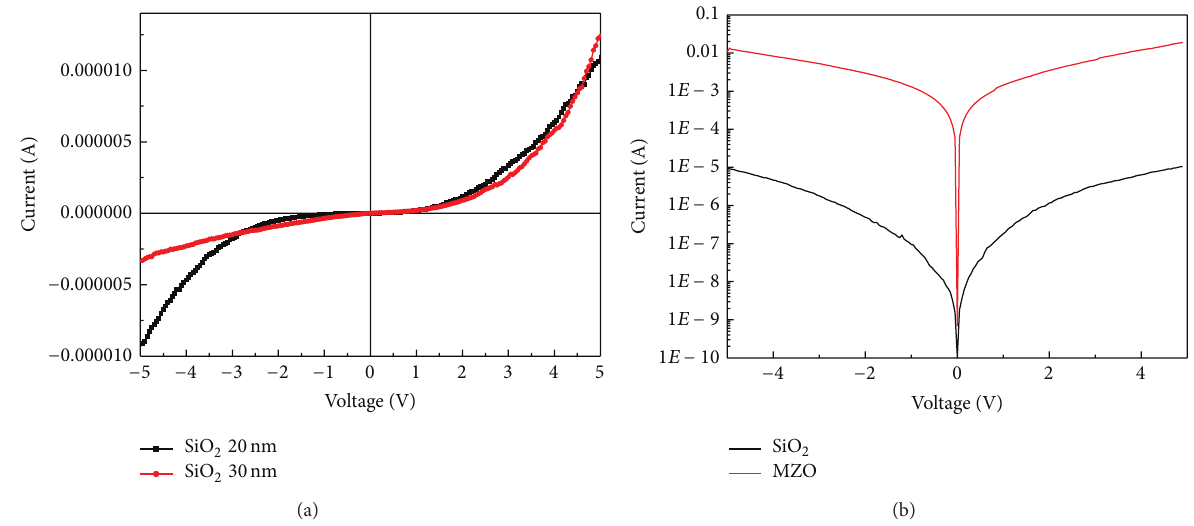
Figure 3: (a) 𝐼 - 𝑉 characteristics of ZnO:YAG-based MIS LED with SiO 2 insulator layer of varying thickness. (b) 𝐼 - 𝑉 characteristics of ZnO:YAG-based MIS LED with different insulator layers with a thickness of 200 nm.